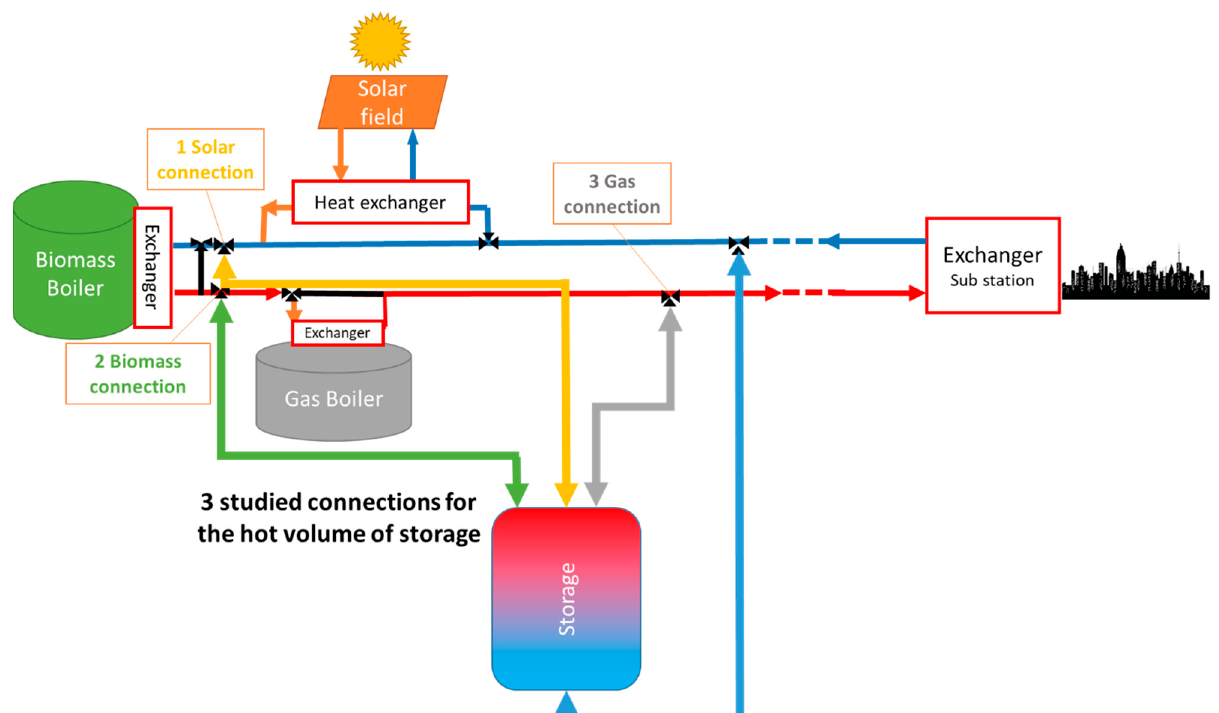
Figure 12. Study diagram, comparing different connections for hot storage volume (yellow = solar connection, green = biomass connection, grey = gas connection). Table 3. Optimal configuration for each connection